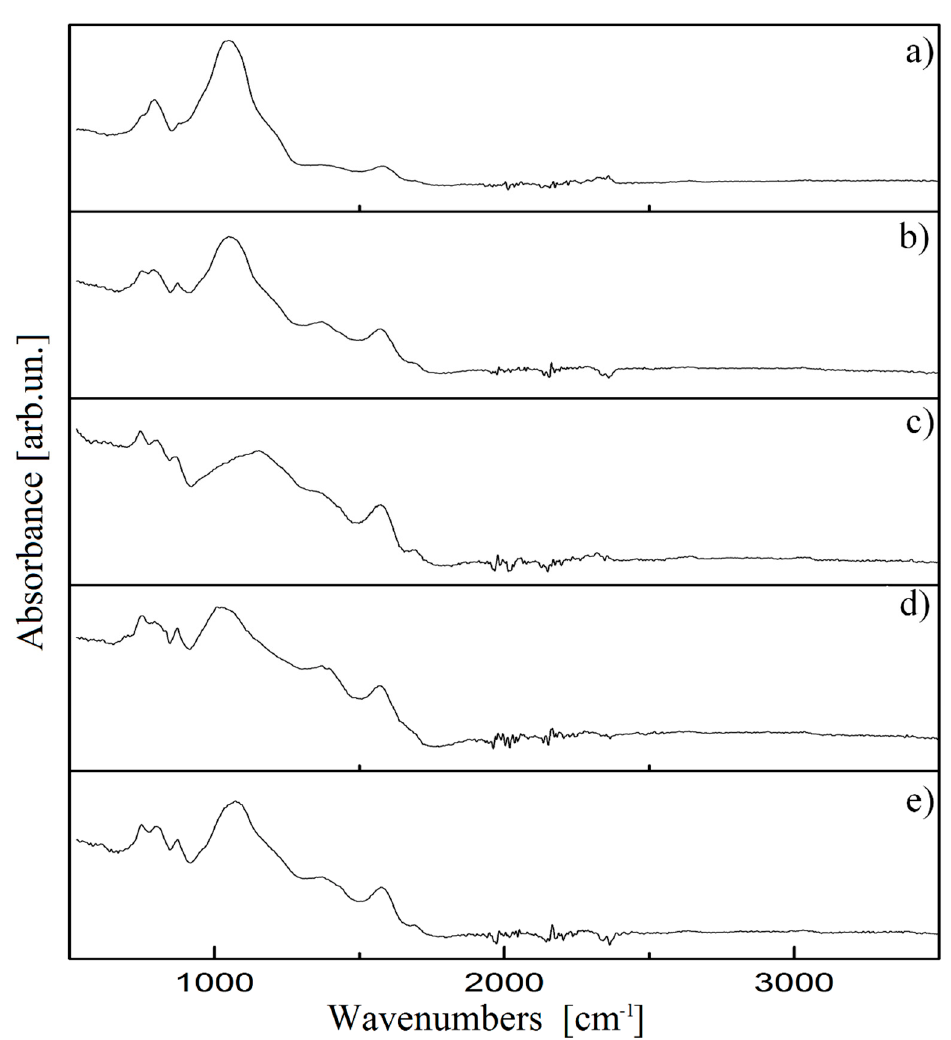
Figure 3. FT-IR attenuated total reflectance (ATR) mode spectra of ( a ) RH, ( b ) MSP, ( c ) SWP, ( d ) OSR, and ( e ) WSP in the region between 500 cm − 1 to 3500 cm − 1 .